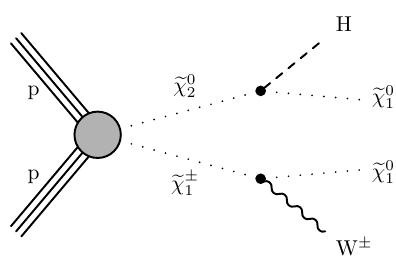
Figure 1 . Diagram corresponding to the SUSY simpli(cid:12)ed model targeted by this analysis, i.e., chargino-neutralino production, with the chargino decaying to a W boson and an LSP, while the heavier neutralino decays to a Higgs boson and an